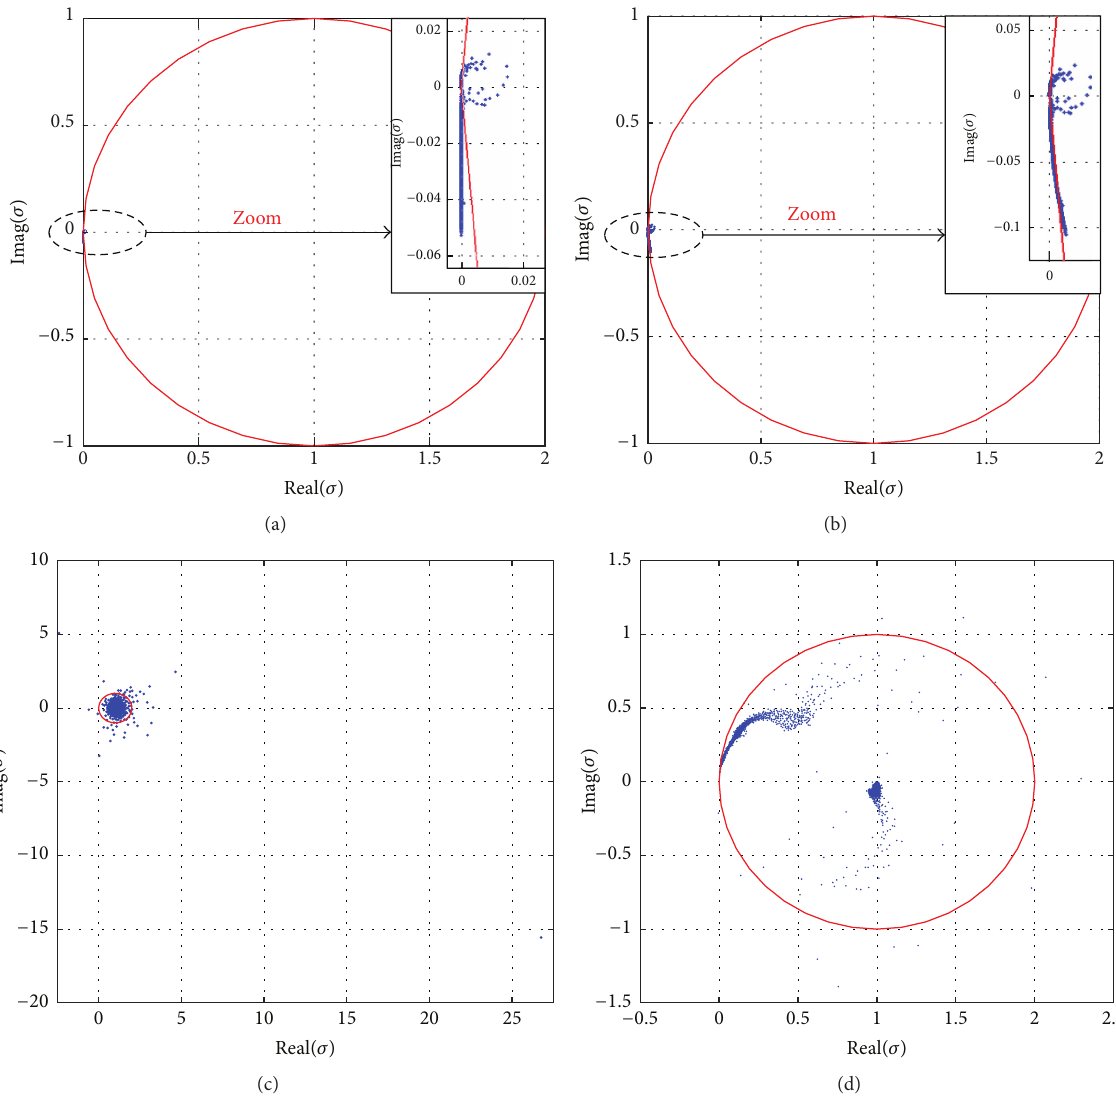
Figure 2: Eigenvalue distribution of the linear systems resulting from the preconditioned linear system equation (12) obtained with (a) EFIE- NO; (b) EFIE-ILUTP5; (c) EFIE-ILUT; and (d) EFIE-DP-ILUT. The red solid circle is the shifted-unit-circle.